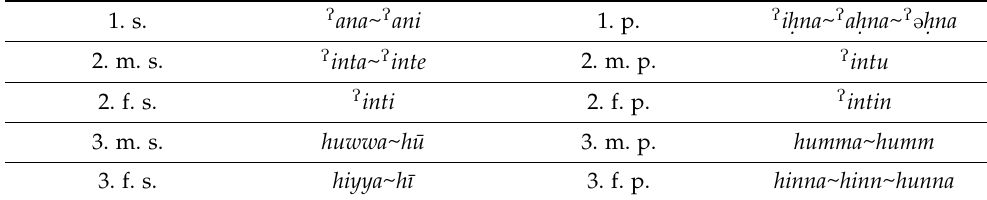
Table 3. Independent personal